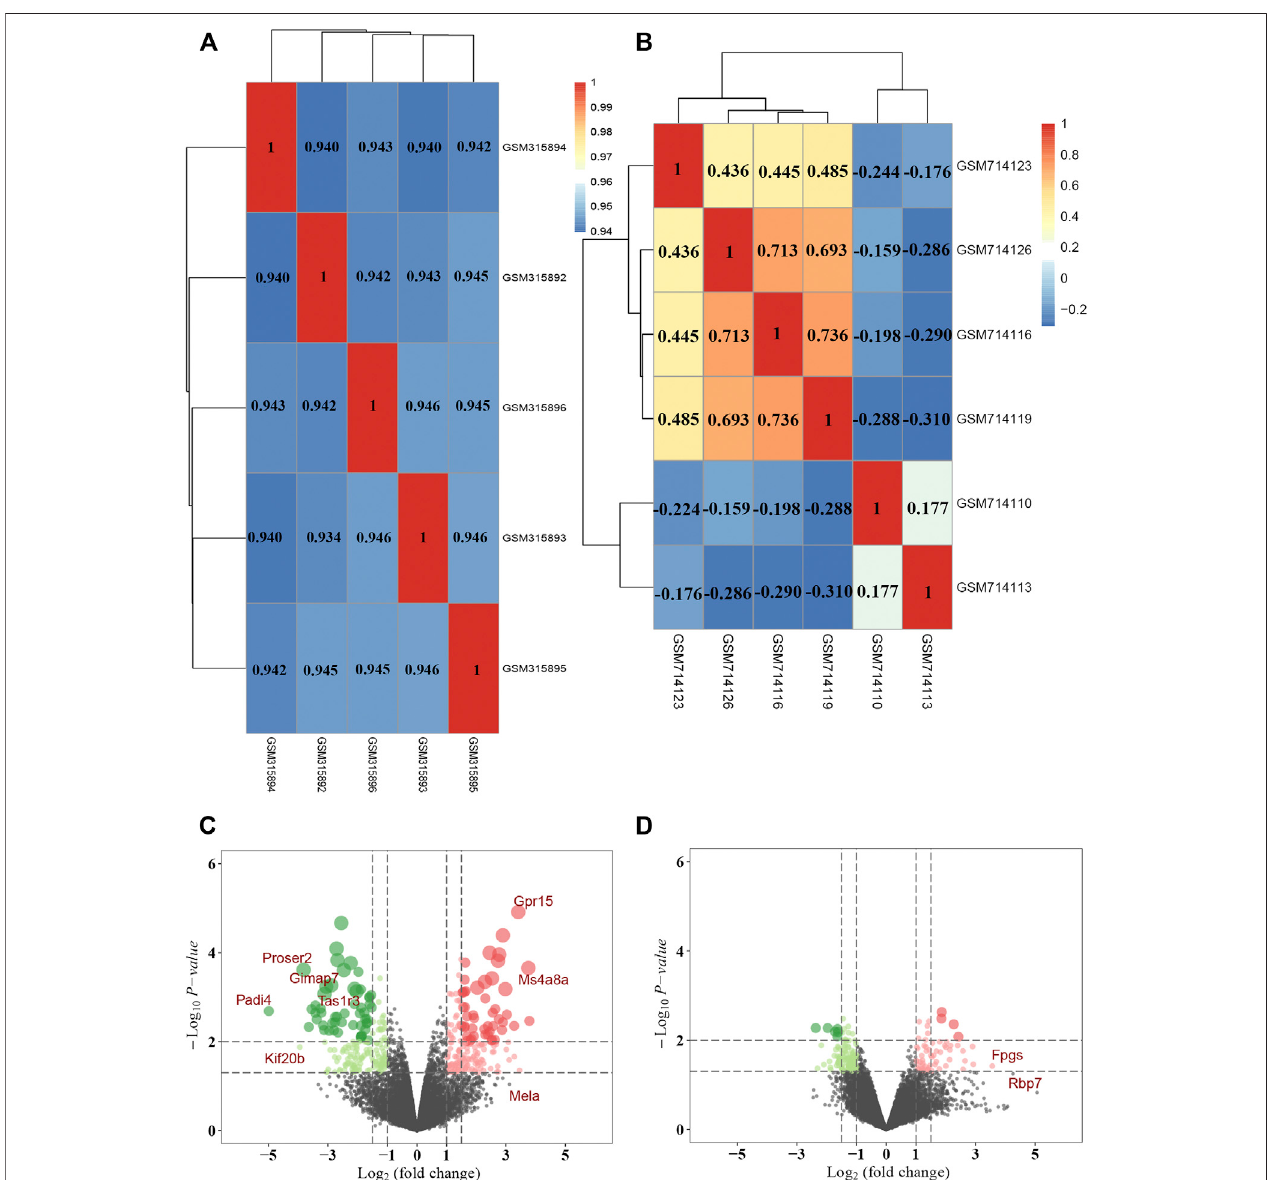
FIGURE4| DEGsidenti fi cationinDRthroughdataminingoutofGEOdatasets.Pearsoncorrelationanalysisof (A) GSE12610datasetand (B) GSE28831dataset. Colorre fl ectsthestrengthofthecorrelation.Thecorrelationcoef fi cientbetween0and1indicatesapositivecorrelation,andanegativecorrelationbetween − 1and0.The greatertheabsolutevalueofthenumberis,thestrongerthecorrelationis. (C) ThevolcanomapshowedthedifferentialexpressionbetweenthenormalgroupandtheDM group in GSE12610 dataset, with red dots representing up-regulated genes and green dots representing down-regulated genes. (D) The volcano map exhibited differential expression between the control and DR groups in the GSE28831 dataset.